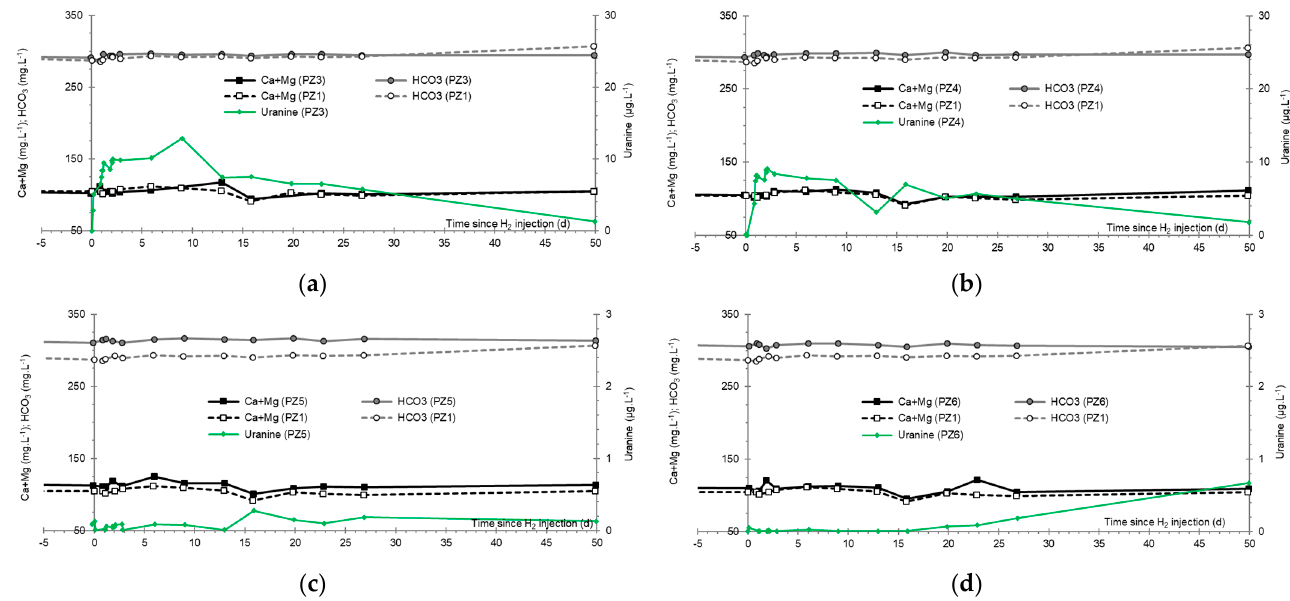
Figure 23. Comparative evolution of the concentrations of dominant ions and tracer at PZ1 (20 m upstream) and at the downstream piezometers: ( a ) PZ3 (5 m); ( b ) PZ4 (20 m); ( c ) PZ5 (30 m); and ( d ) PZ6 (70 m).